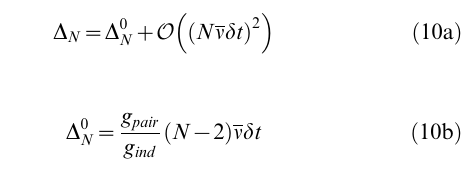
Figure 3. Schematic plot of S ind (black line), ~ SS pair (cyan line) and S true (red line). The better the pairwise model, the closer ~ SS pair is to S true . This is reflected in the normalized distance measure, D N , which is the distance between the red and cyan lines divided by the distance between the red and black lines.